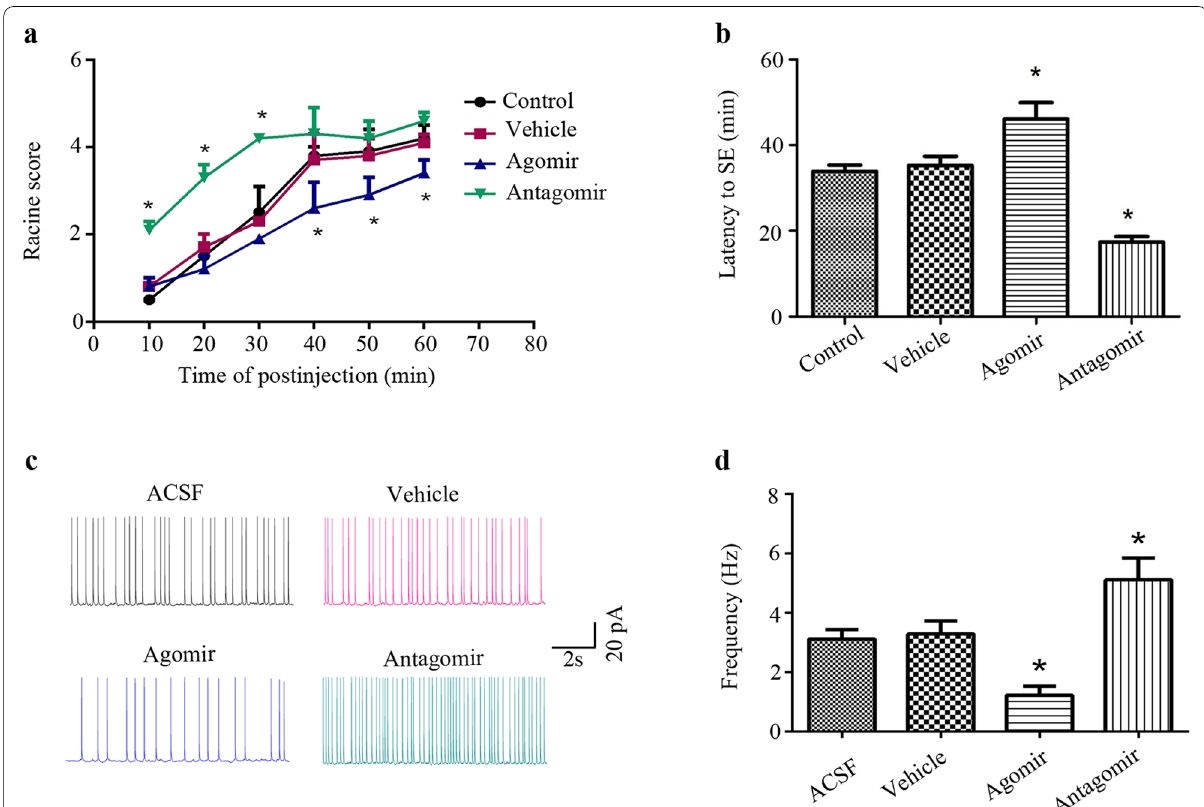
Fig. 3 Effects of the agomir and the antagomir on the pilocarpine-induced SE ( n the SE Racine scale was significantly decreased in the agomir group at 40 min, 50 min and 60 min (* P < 0.05), and it was significantly increased in the antagomir group at 10 min, 20 min, and 30 min (* P < 0.05). b The latency of the agomir group (46.13 the SE group ( P < 0.05), and the latency of the antagomir group was significantly shorter than that of the SE group (17.38 was no significant difference in the latency between the SE group (33.88 c Representative images of action potentials of pyramidal neurons in the CA1 region in Mg 2 + -free ACSF in the presence of vehicle, the agomir and the antagomir. No difference was observed between the ACSF and vehicle groups. d Compared with the vehicle group, the agomir